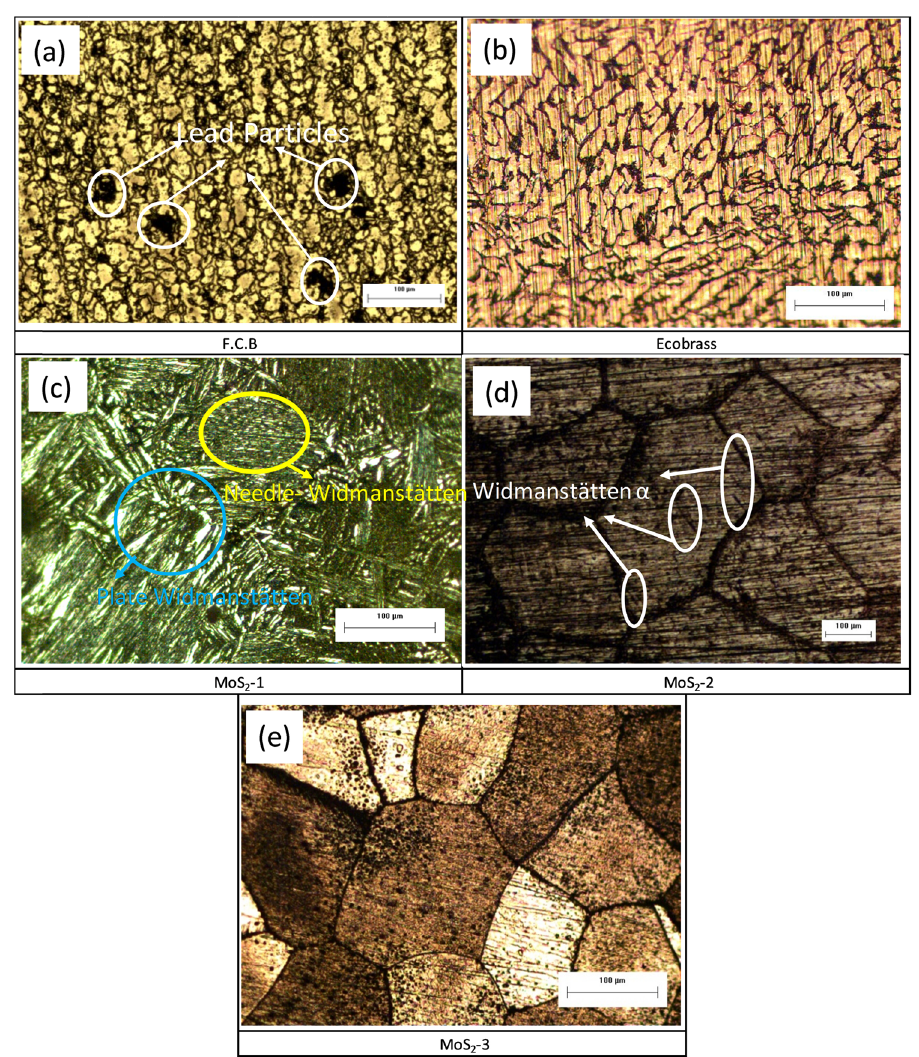
Figure 3: Microstructure on longitudinal cross - section of samples taken by optical microscopy ( a ) F.C.B; ( b ) Ecobrass; ( c ) MoS 2 - 1; ( d ) MoS 2 - 2; and ( e ) MoS 2 -